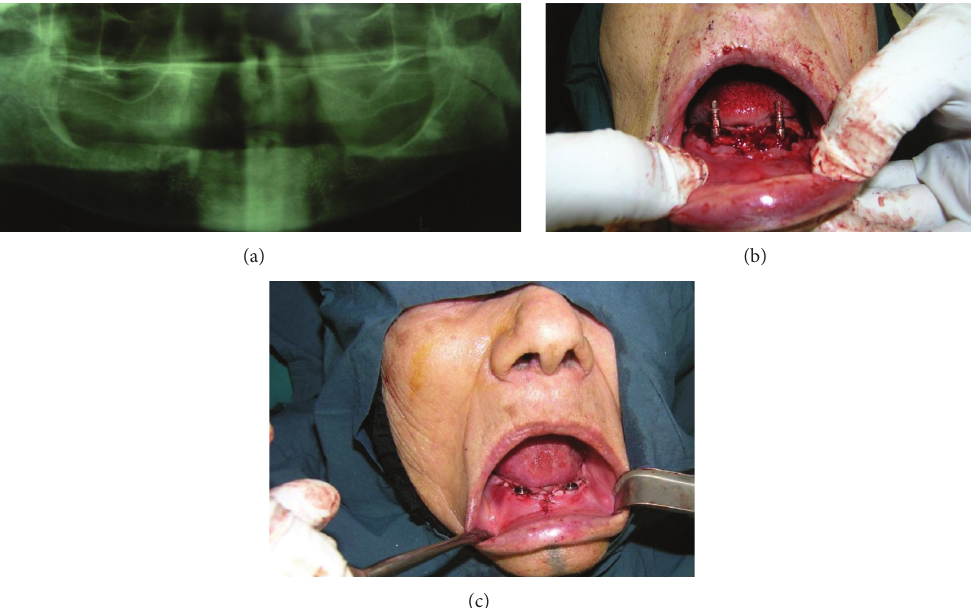
Figure 4: (a) Patient number two, panoramic X-ray before surgery. (b) Patient number two, surgery day photo. (c) Patient number two, after surgery